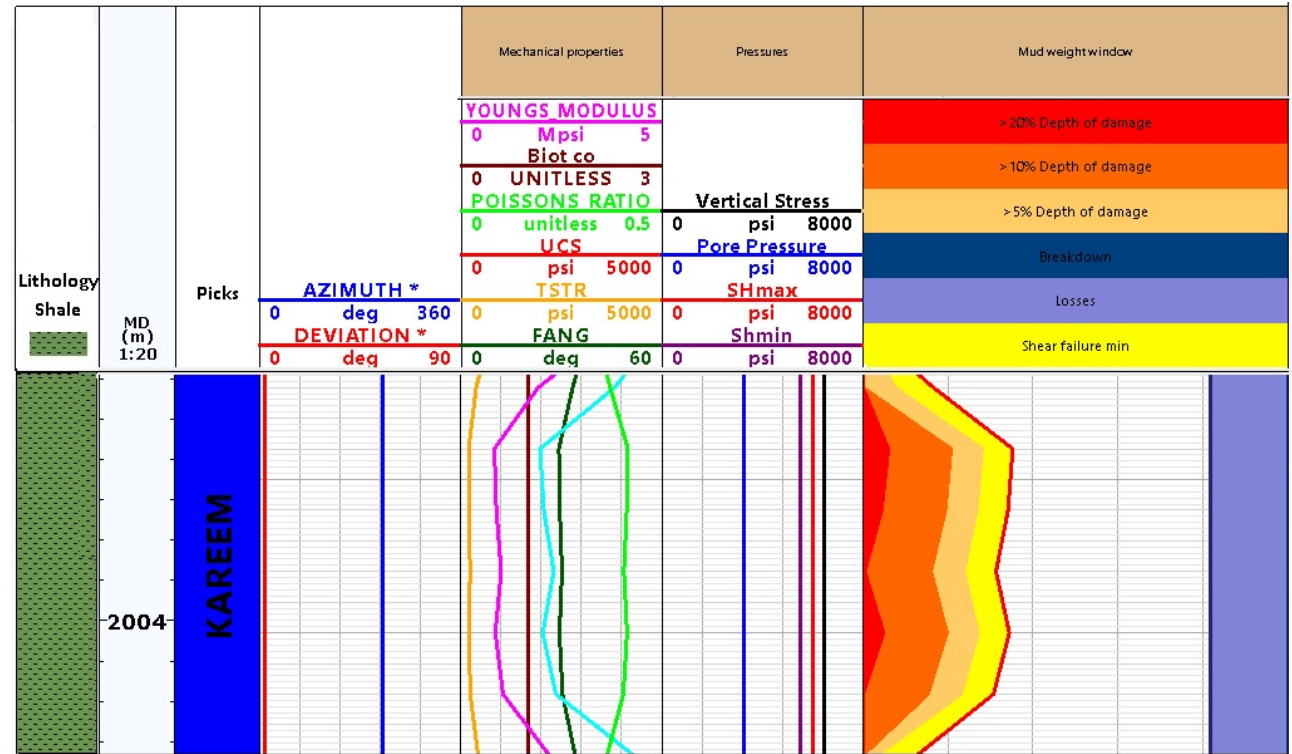
Figure 10. WBS model of Kareem Formation in El Morgan-A1 well. Track 1 (Lithology), Track 2 (Depth), Track 3 (Picks), Track 4 (Hole deviation and Azimuth), Track 5 (mechanical properties), Track 6 (Vertical stress, Shmin, SHmax, and pore pressure), Track 7 (mud weight window). For the different colors in track 7, readers should refer to Figure 4 in this article.